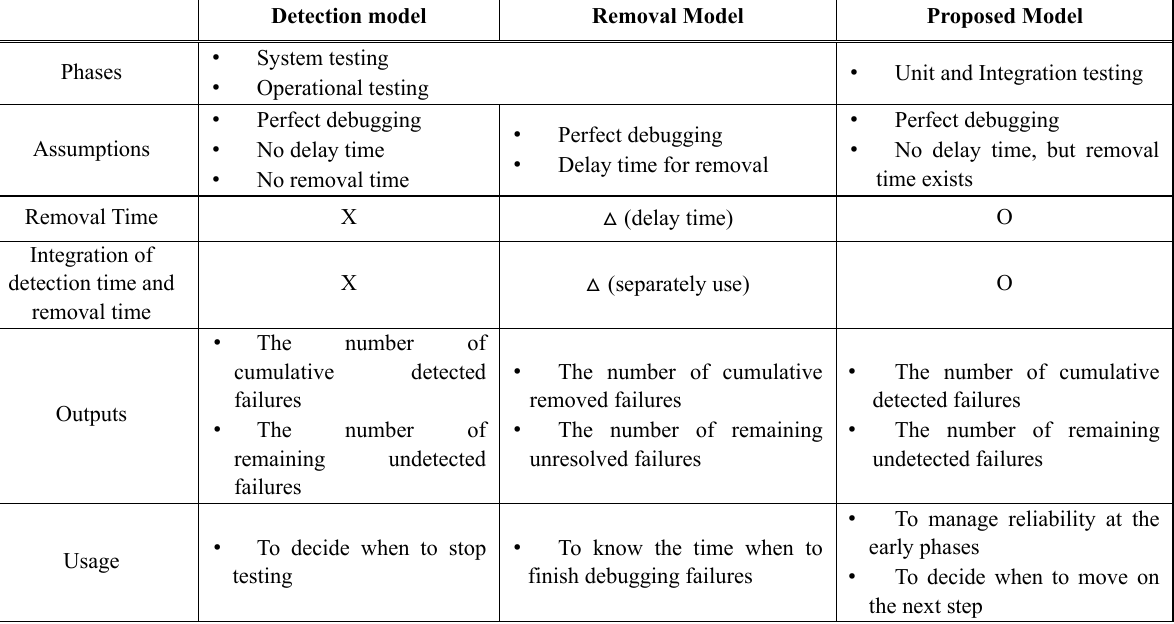
Table 1. Comparing of Existing Models and the Proposed